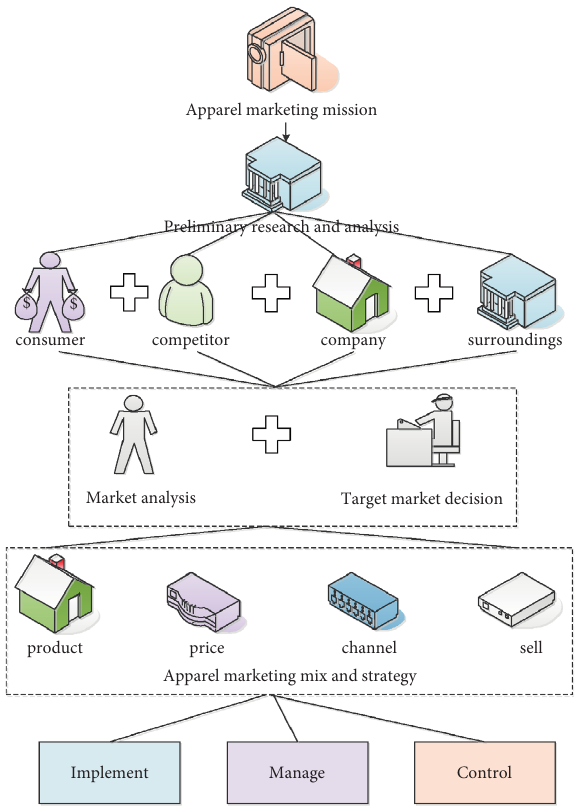
Figure 2: Chain relations in the marketing process of apparel